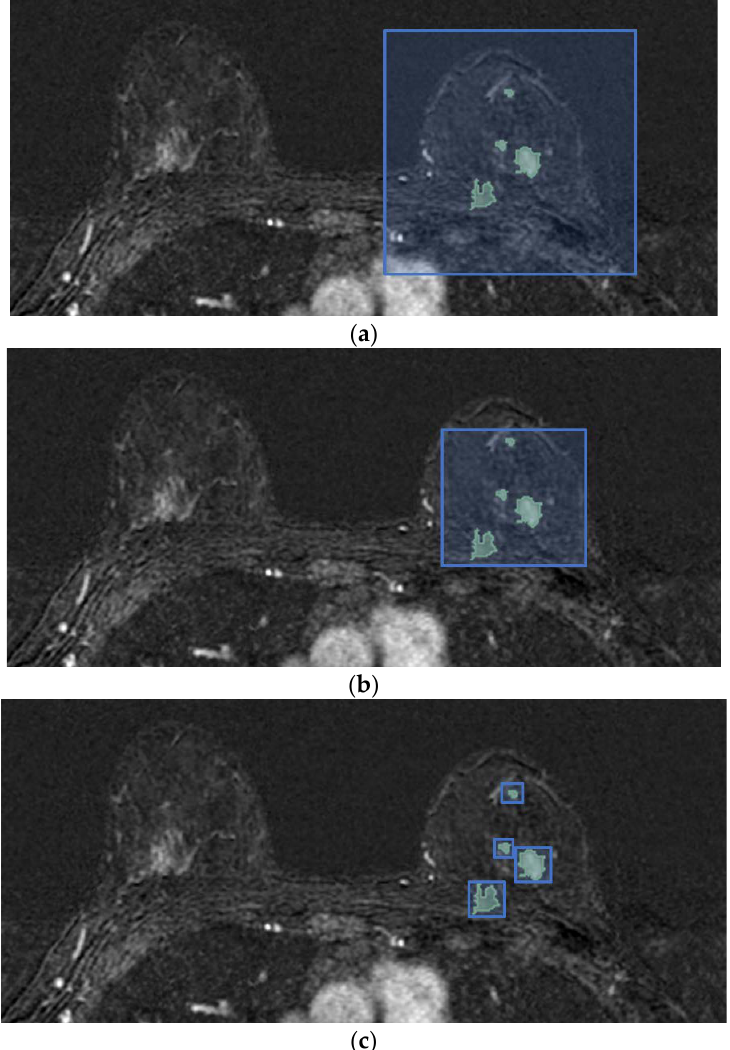
Figure 2. Differences in axial projections of the implemented tumor bounding options. ( a ) In the SFB, a fixed-size 3D bounding box is used; ( b ) in the SVB option, the smallest 3D bounding box circumscribed to the tumor region is considered, and ( c ) in the SLVB, the SVB option is applied to each lesion of the patient.